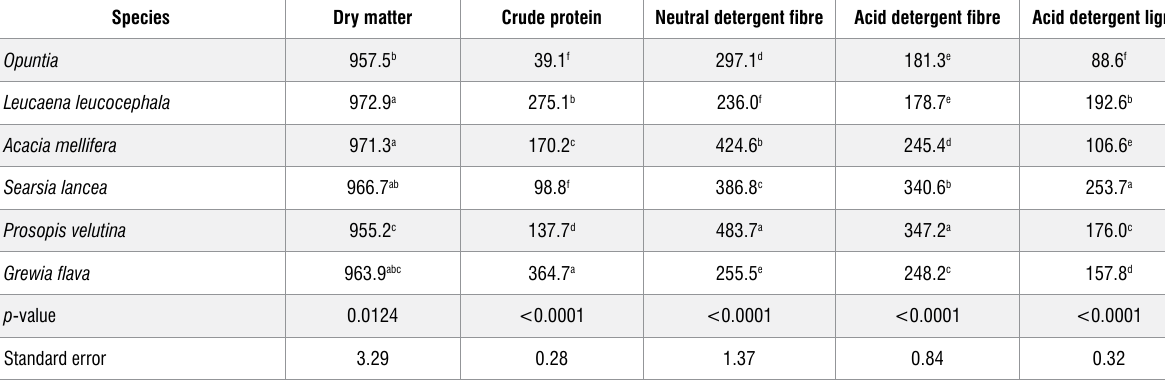
Table 1: Nutritional composition (g/kg dry matter) of Opuntia and legume browse species Species